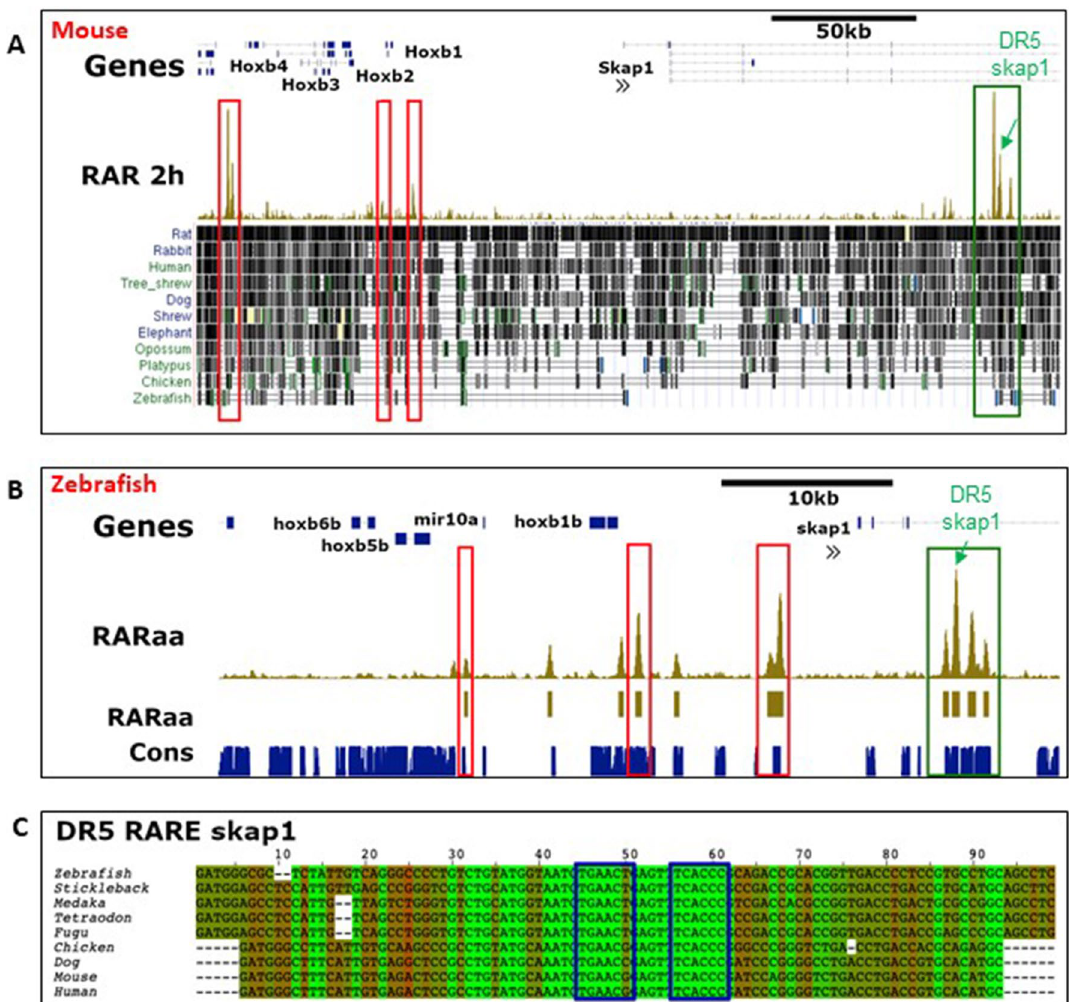
Figure 4. Examples of RARa binding sites conserved among vertebrates. ( A , B ) Genome browser views around HoxB-Skap1 locus in mouse ( A ) and zebrafish ( B ) showing the RAR binding sites detected by ChIP-seq (in gold) in both species. All RAR sites are located in CNEs but only the RAR sites located in skap1 gene 4th intron (green box) display sequence conservation from zebrafish to human. Other RAR sites located at similar places in the murine and zebrafish loci (red boxes) are probable orthologous RAR sites but their sequences cannot be aligned between zebrafish and mice. Conserved regions from the UCSC genome browser is shown below the murine RAR ChIP-seq peaks in panel ( A ). ( C ) Alignment of 9 vertebrate sequences corresponding to the second RAR sites located in skap1 gene 4th intron, showing the conservation of a DR5-like motif (blue boxes; inverse orientation) recognized by the RAR–RXR complex. Sequences highlighted in green are identical in all 9